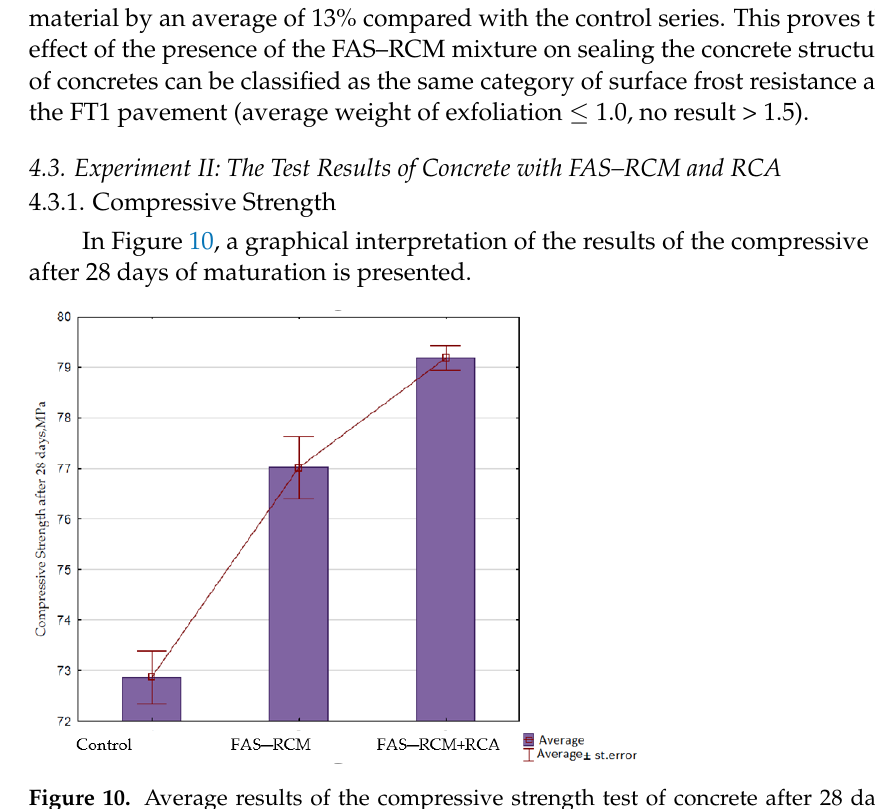
Table 9. Frost resistance results after 28 cycles of freezing and thawing.